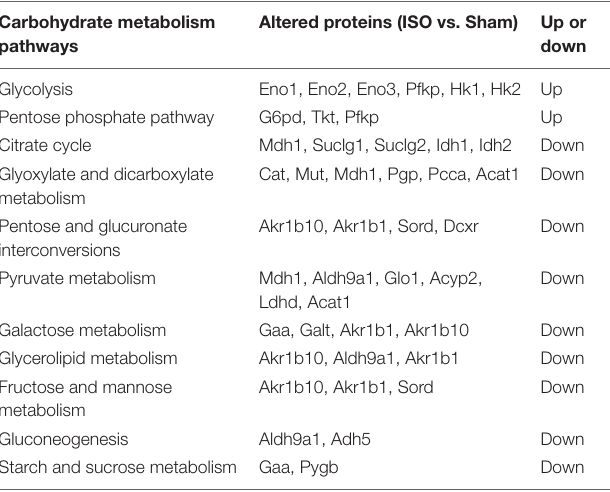
TABLE 1 | The altered proteins enriched in carbohydrate metabolism pathways evoked by ISO. Carbohydrate metabolism Altered proteins (ISO vs. Sham) Up or pathways